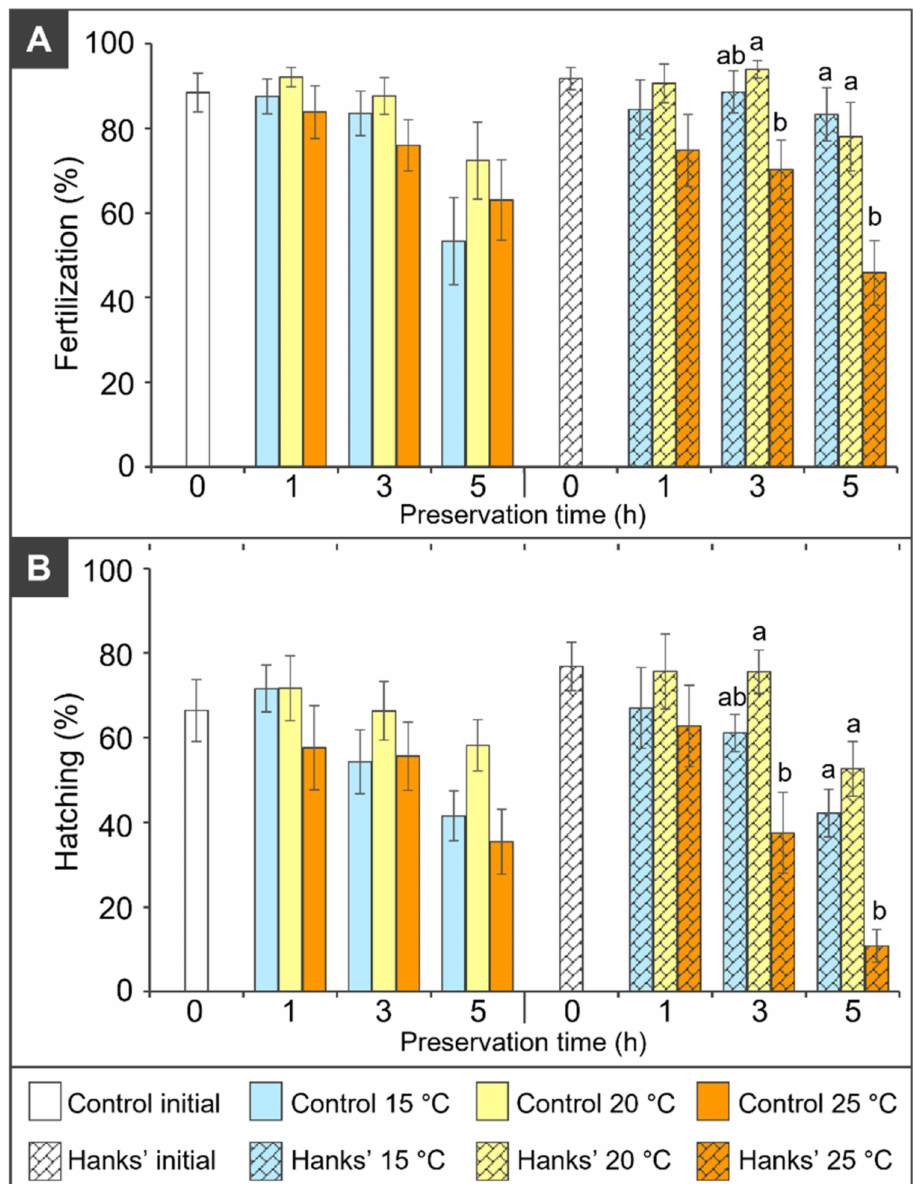
Figure 5. Developmental capacity after preservation of ovulated eggs of kawakawa Euthynnus affinis in different temperatures when compared between 15 ◦ C, 20 ◦ C, and 25 ◦ C. ( A ) Fertilization rate and ( B ) hatching rate after the preservation of ovulated eggs in Hanks’ solution and without artificial medium (control) for 0, 1, 3, and 5 h at 15 ◦ C, 20 ◦ C, and 25 ◦ C. Different superscript letters indicate significant differences determined by the Steel–Dwass test ( p <